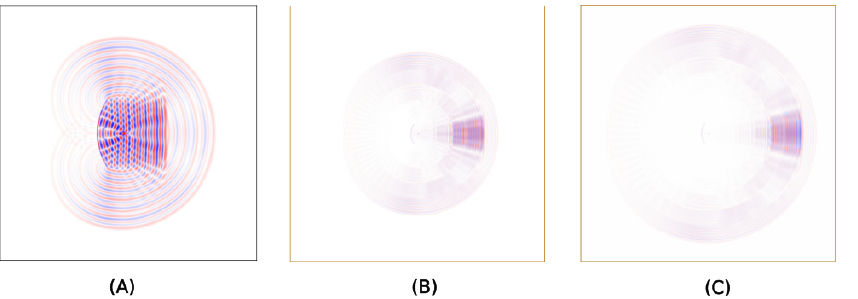
Figure 16. Comparison between the execution times ( × 10 2 ) obtained for the parabolic propagation at 20.00 Ghz.